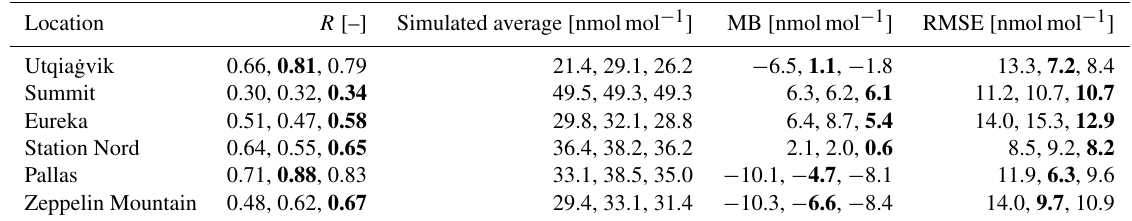
Table 3. Statistics for the modeled ozone mixing ratio in comparison to in situ measurements at different locations from 1 February to 1 May 2019. The three values in each entry are for the three simulations in this order: infinite FY ice bromide, low bromide, medium bromide. The best value is marked in bold.